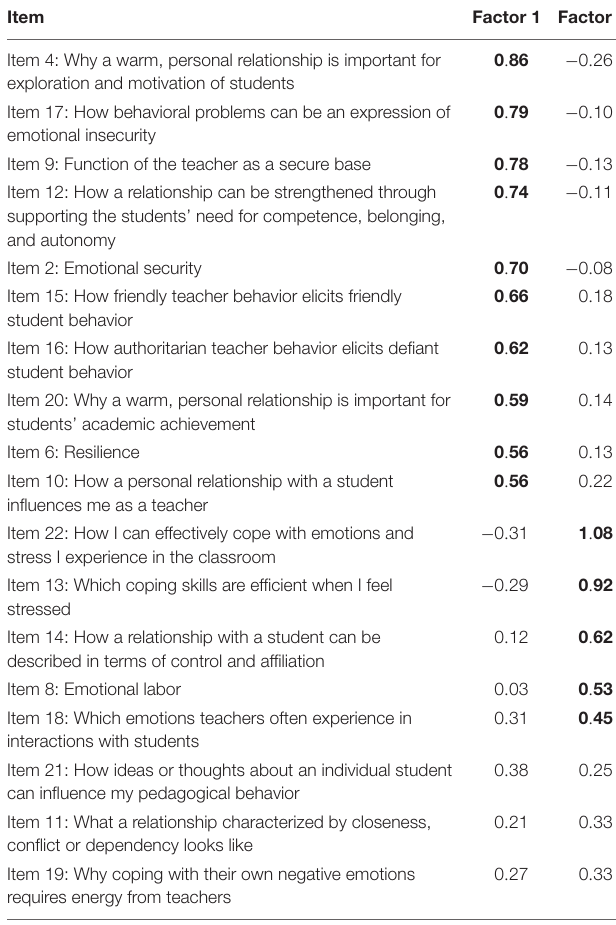
TABLE 3 | Results of exploratory factor analysis for knowledge: factor